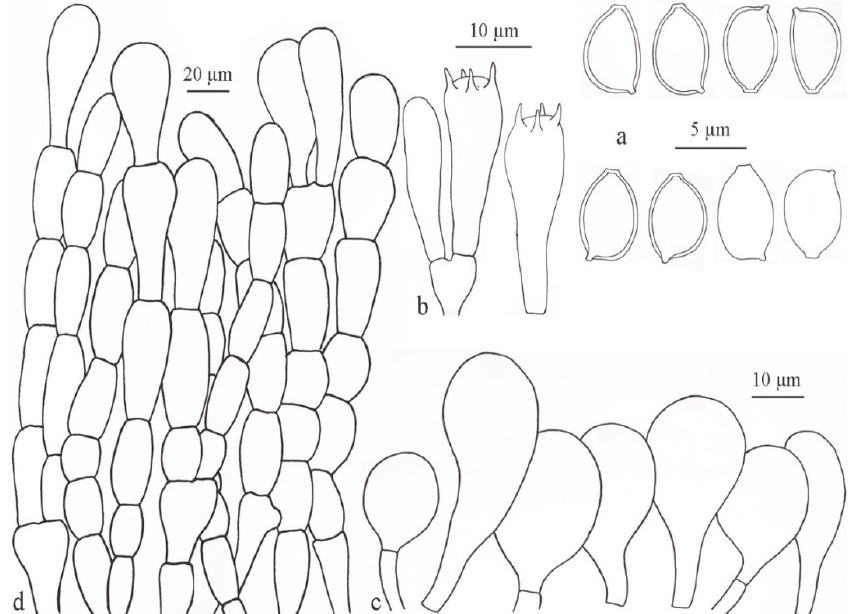
Figure 14. Microcharacters of Clarkeinda trachodes (MFLU 192-351). ( a ) basidiospores. ( b ) basidia. ( c ) cheilocystidia. ( d ) pileus covering.